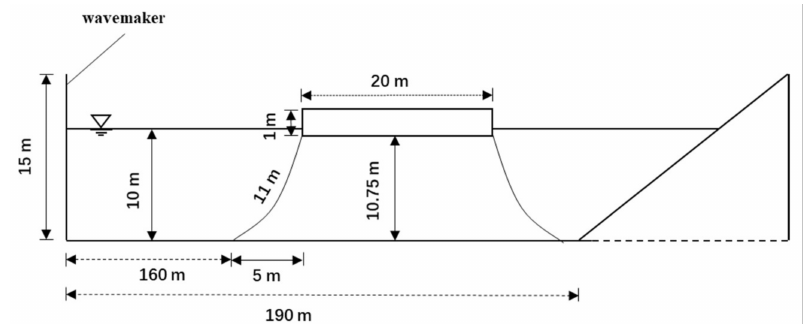
Figure 11. Initial setup of the application